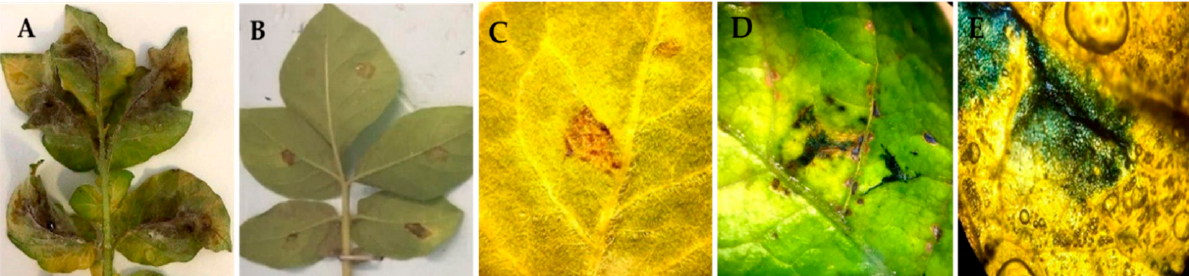
Figure 2. Development of hypersensitive response (HR)-like lesions on detached potato leaves pre-exposed to Z-3-HAC after spot-inoculation with P. infestans sporangial suspension (5 × 10 4 sporangia mL − 1 ) at 1 h postexposure. ( A ) unexposed, infected leaf; ( B , C ) restricted area consisting of HR-like lesions; ( D , E ) Evans-blue-based detection of dead cells in lesions. Dead cells in HR-like lesions demonstrated by Evans blue stained in blue. Symptoms were assessed seven days after infection.